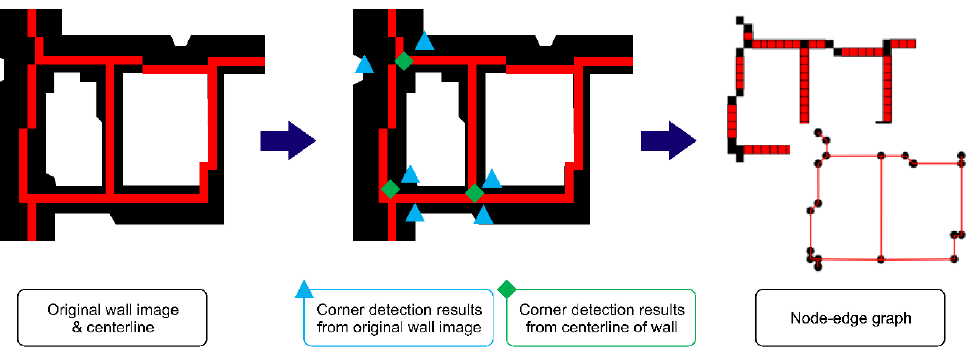
Figure 3. Centerline detection and node-edge graph.